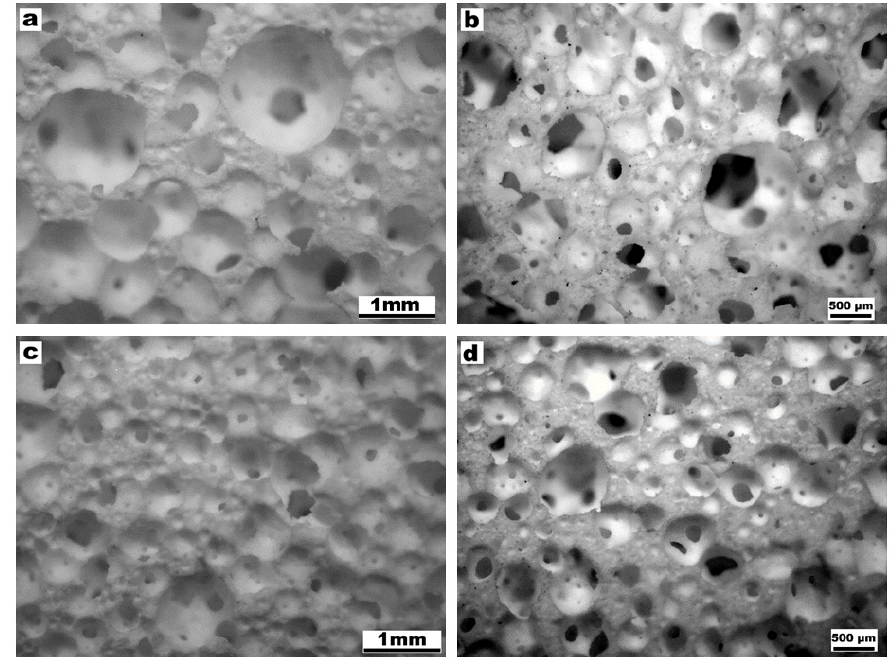
Figure 3. Microstructural and morphology details of W-D foams with different solid content of the starting suspensions, before and after firing at 1000 °C, respectively: ( a , b ) foams with 60 wt %; ( c , d ) foams with 65 wt %.